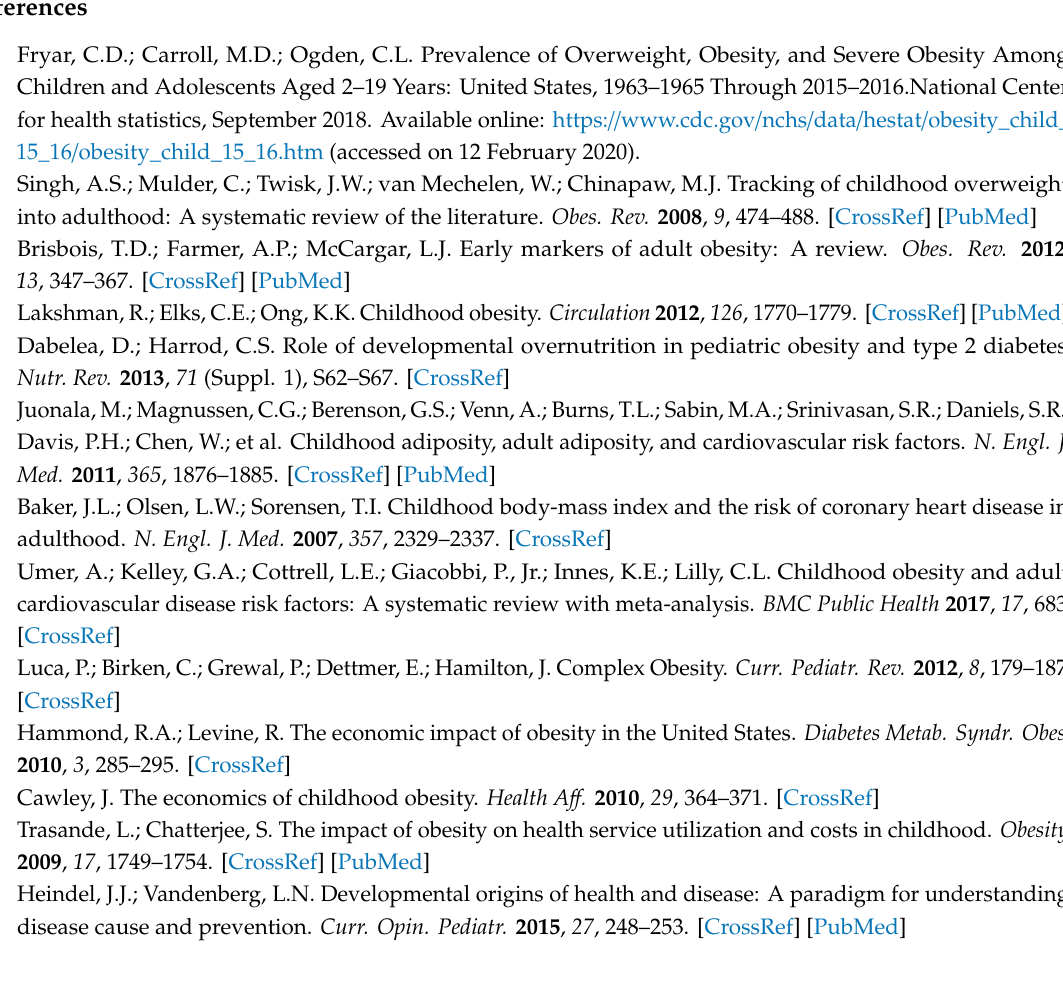
Figure S1: BMI-z-score trajectories among the CANDLE children; Figure S2: Early childhood energy intake trajectories among the children of black and white mothers; Supplemental Table S1: Food items within food group; Table S2: Mothers’ eating frequencies of food groups in a month according to quartiles of the fast food pattern score; Table S3: Mothers’ eating frequencies of food groups in a month according to quartiles of the processed food pattern score; Table S4: Mediation analysis of potential mediators for the associations between the maternal fast food pattern and the childhood rising-high-BMI trajectory and overweight / obesity risk at age 4; Table S5: Select nutrient intakes (per 1000 kcal) according to quartiles of the fast food pattern